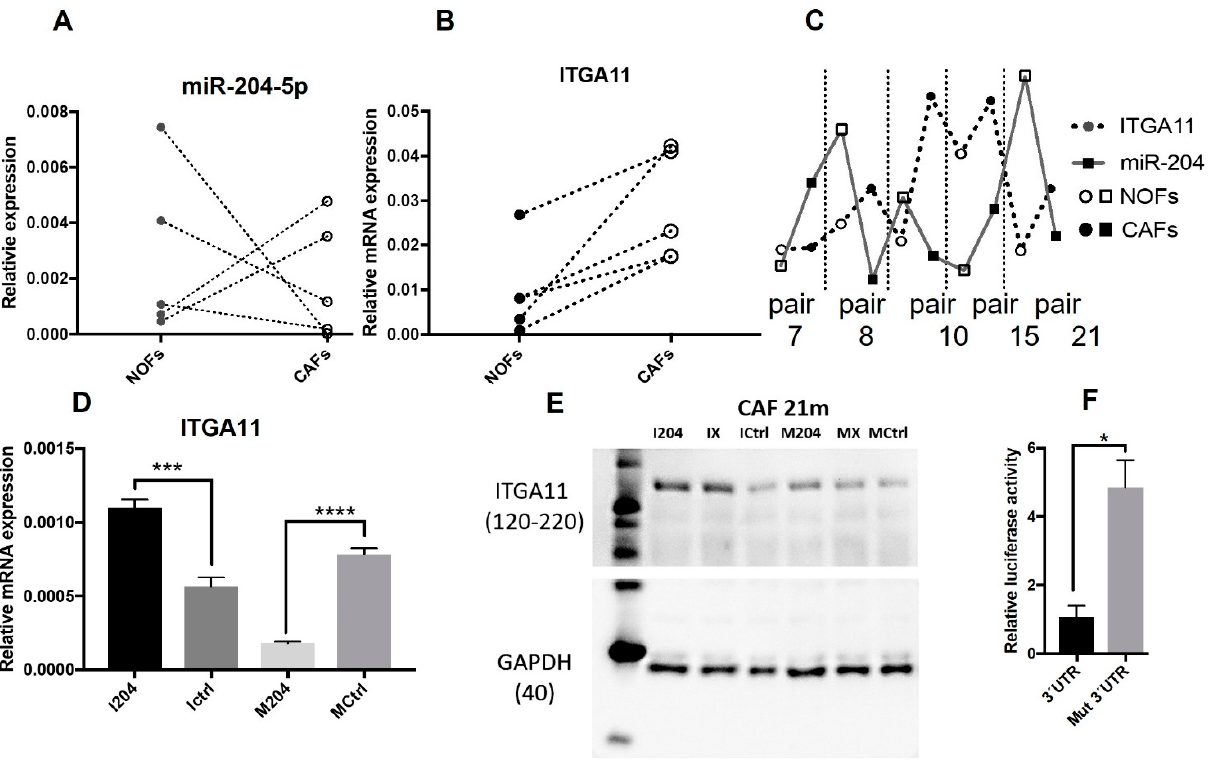
Figure 2. ITGA11 and its regulation by miR-204: relative expression of ( A ) miR-204 and ( B ) ITGA11 in NOFs compared with matched CAFs (connected by dotted lines), and the corresponding ( C ) expression correlation between miR-204 and ITGA11. ( D ) mRNA and ( E ) protein (Western blot image) regulation of ITGA11 by miR204, 48 h post transfection. ( F ) Luciferase activity in CAFs in one with miR-204 target site and another with mutated sequence in 3 ′ UTR for ITGA11 in miR target reporter assay (* p < 0.05, *** p < 0.0005, **** p < 0.00005, unpaired Student’s t -test, n = 4).